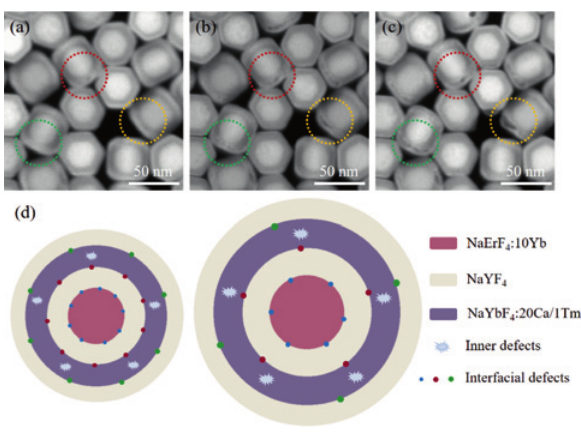
Figure 3: UC emission spectra (a) and Schematic illustration (b) of the core/triple- shell NCs. Excitation power dependent digital photographs of the core/triple-shell NCs with 57 nm (c) and 124 nm (d), respectively. (e) and (f) are the CIE chromaticity coordinates corresponding to (c) and (d), respectively.